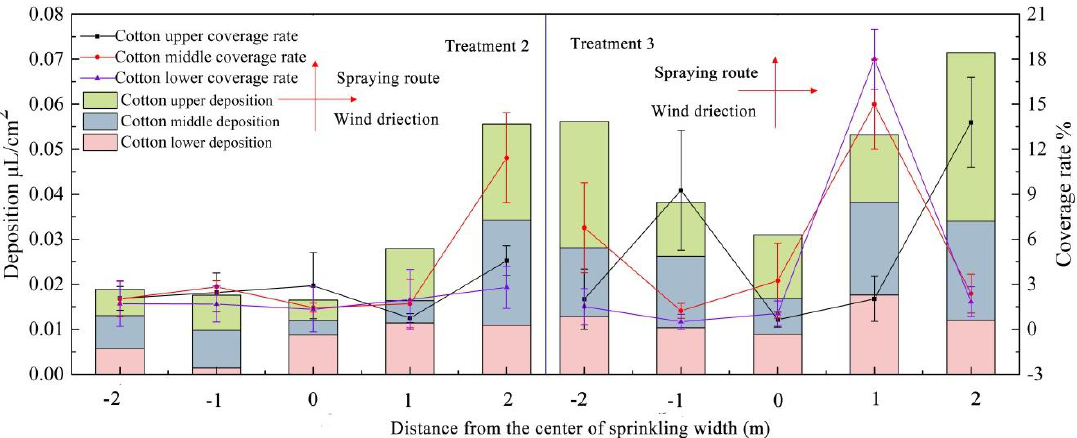
Figure 5. Distributions of droplet deposition at different flight heights. Note: Treatments 2 and 3 were low-height and low-volume spraying by the UAV at working heights of 1.5 and 2 m above the canopy. The upper, middle, and lower layers of cotton are divided according to Figure 2.